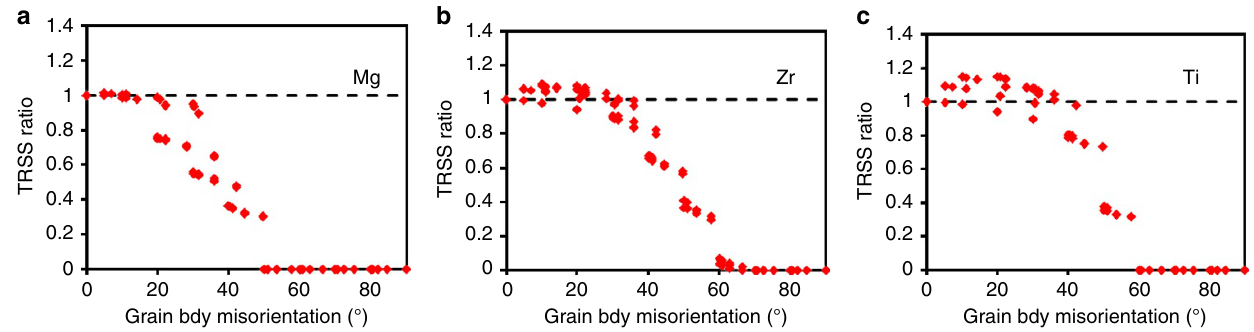
Figure 6 | FFT model-based evolution of twin transmission indicator. Evolution of the TRSS ratio (TRSS tip /TRSS SX ) in region O with grain boundary misorientation angle for ( a ) Mg, ( b ) Zr and ( c )